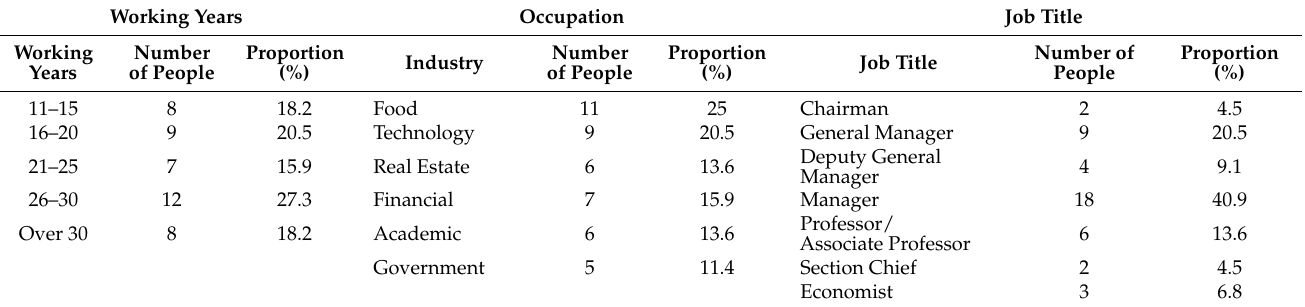
Table 3. Descriptive statistical description of respondents of modified Delphi